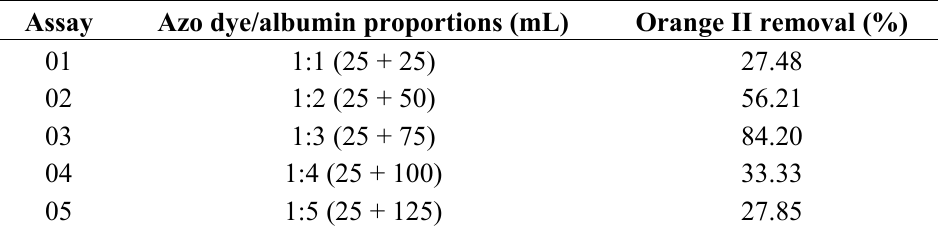
Table 2. Interaction of the dye Orange II and albumin proportions related to concentrations maintained in the pH 3 and, contact time of 90